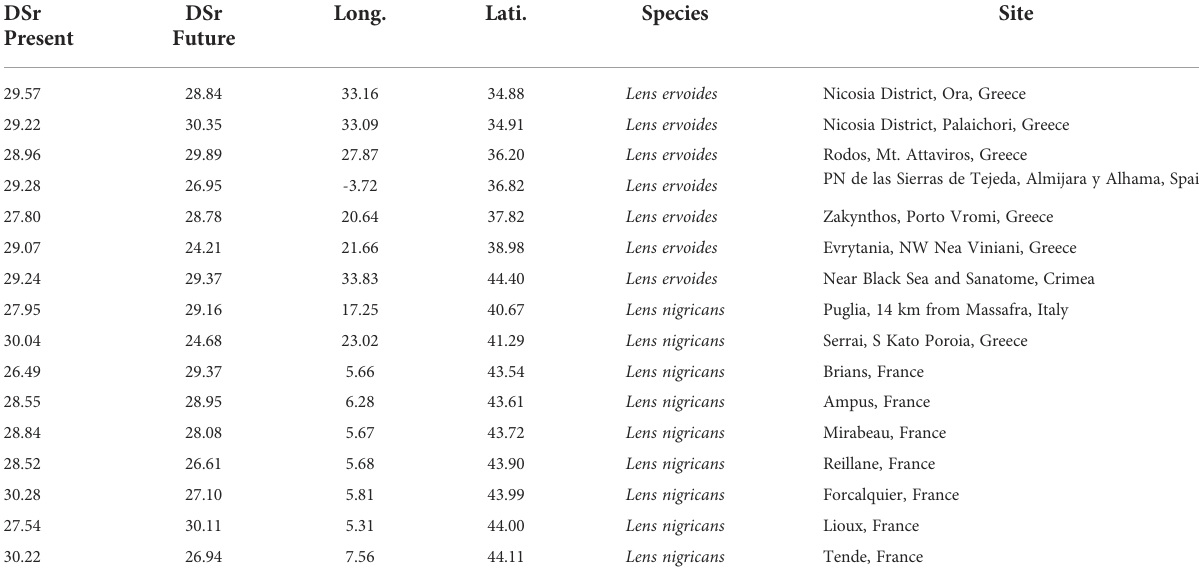
TABLE 2 Selected subset of wild lentil populations for in situ conservation, occurring in protected areas and most likely to be rust-resistant at present and in the future according to the tested climate change projection models. DSr DSr Long.